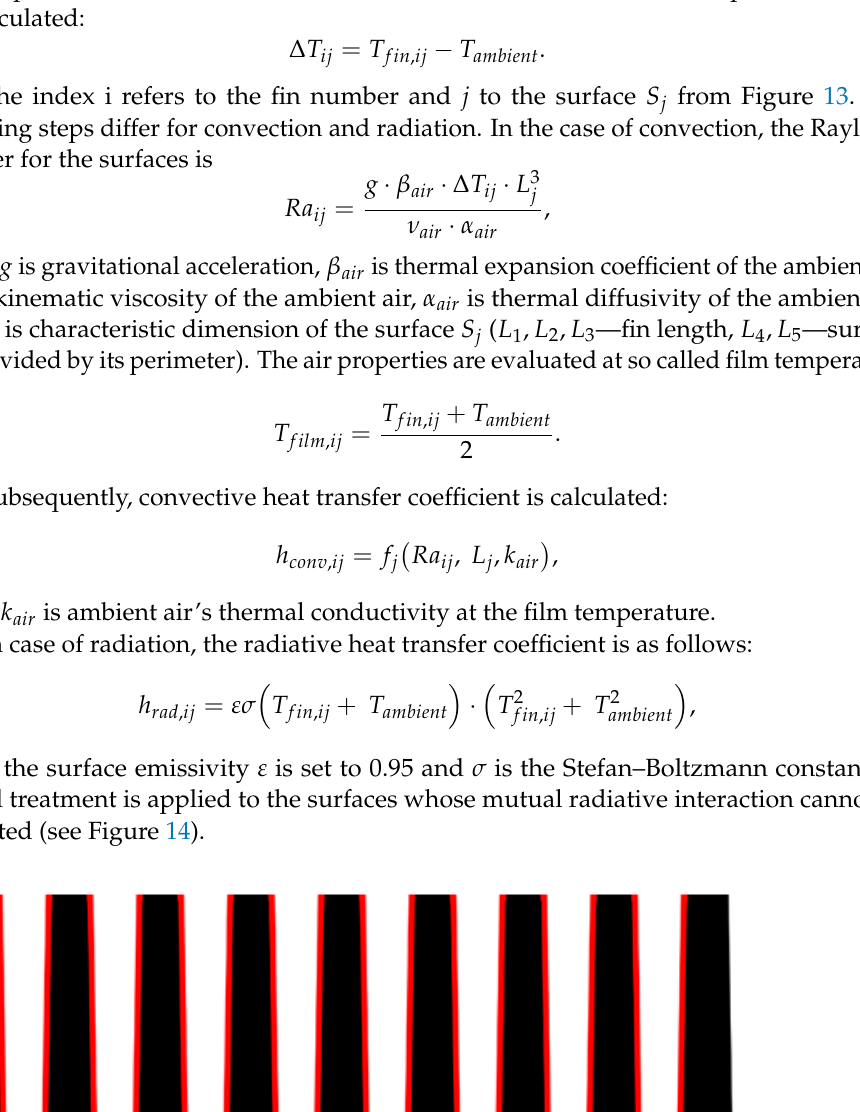
Figure 15. Two-dimensional cut of a simplified fin model used to evaluate the ambient view fac- tor. Then, the radiative heat transfer coefficient is modified: ℎ (cid:3045)(cid:3028)(cid:3031),(cid:3036)(cid:3037)∗ = 𝐹 (cid:3028)(cid:3040)(cid:3029) ⋅ ℎ (cid:3045)(cid:3028)(cid:3031),(cid:3036)(cid:3037) . (7) For surfaces not affected by mutual radiation, 𝐹 (cid:3028)(cid:3040)(cid:3029) is equal to 1. Finally, the indi- vidual heat flows 𝑄 (cid:3036) from the fins are 𝑄 (cid:3036) = (cid:3533) 𝑄 (cid:3036)(cid:3037) (cid:3037) , 𝑄 (cid:3036)(cid:3037) = (cid:3435)ℎ (cid:3030)(cid:3042)(cid:3041)(cid:3049),(cid:3036)(cid:3037) + ℎ (cid:3045)(cid:3028)(cid:3031),(cid:3036)(cid:3037)∗ (cid:3439) ⋅ 𝐴 (cid:3037) ⋅ 𝛥𝑇 (cid:3036)(cid:3037) , (8) where 𝐴 (cid:3037) is the area of surface 𝑆 (cid:3037) . The heat flows through individual fins are displayed in Figure 16, which compares heat sinks placed in the “upside-down” position. It is clear to see that the amount of trans- ferred heat via fins is higher in the case of the melt entering through the long side of the heat sink’s base. Moreover, the influence of radiation on the outermost fins is evident as